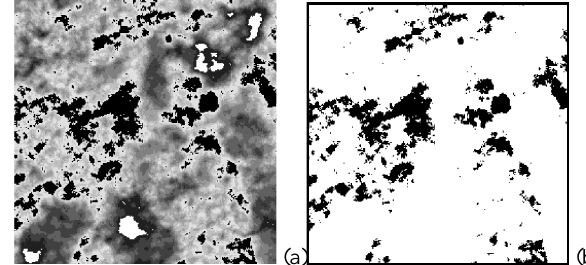
Fig. 4. The obtained results for the Fuzzy c-means method: (a) the image segmented with nine clusters; and (b) the binary image ob- tained from the segmentation process, where 0 value corresponds to the pore space class and 1 value corresponds to the soil solid class.